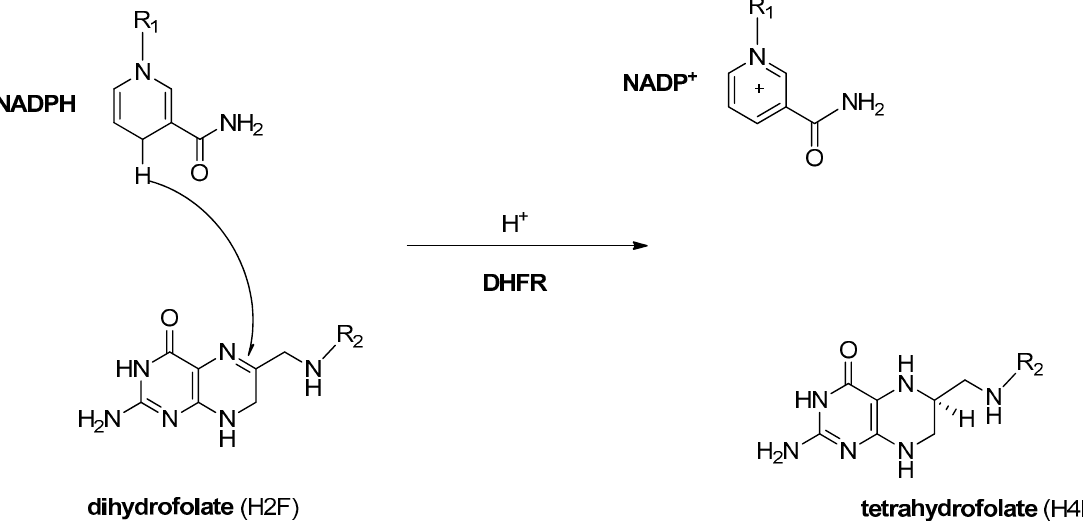
Scheme 1. Schematic representation of the reduction reaction catalyzed by dihydrofolate reductase